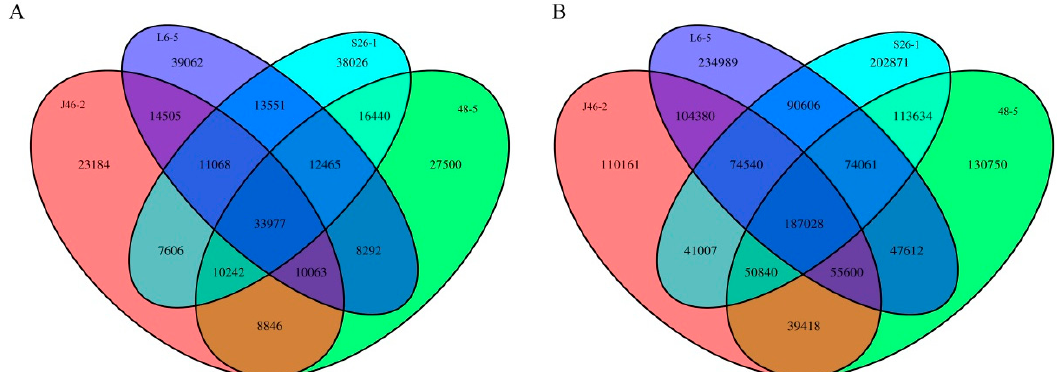
Figure 1. A Venn diagram showing the numbers of SNPs (Single Nucleotide Polymorphisms) that overlapped between the four EMS (ethyl methanesulfonate)-induced mutants. ( A ) SNPs between the four EMS-induced mutants, ( B ) indels between the four EMS-induced mutants. Table 3. Genome-wide analysis of the SNPs (Single Nucleotide Polymorphisms) and indels’ numbers between the wild type and four ethyl methanesulfonate-induced eggplant mutants.